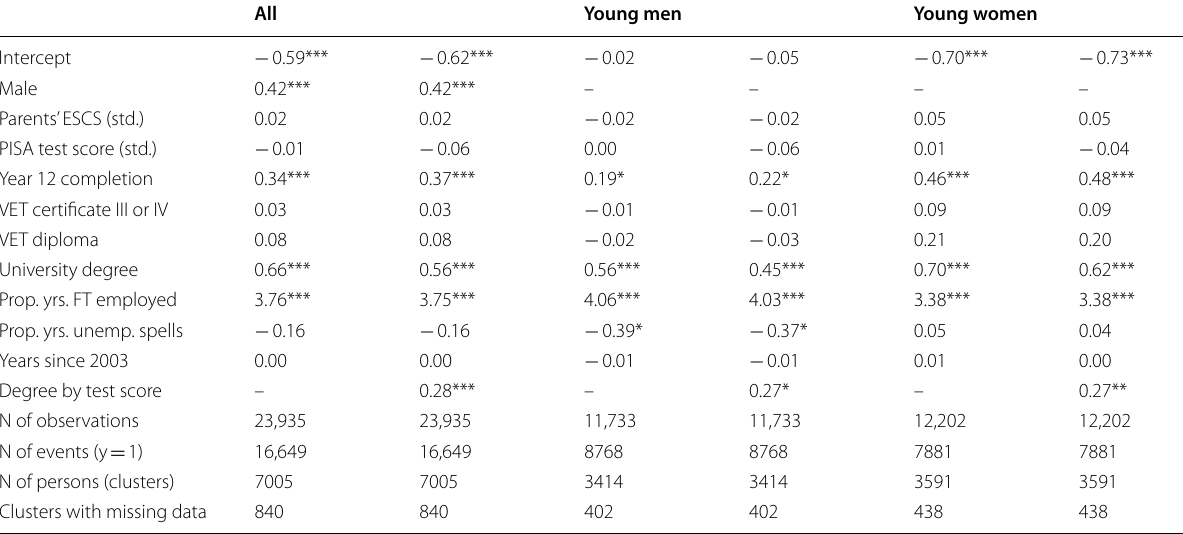
Logit regression coefficients from repeated design analyses. Contrast: employed full-time vs not employed full-time. Full-time study observations excluded. Weighted for sample selection and attrition. See Table 1 for